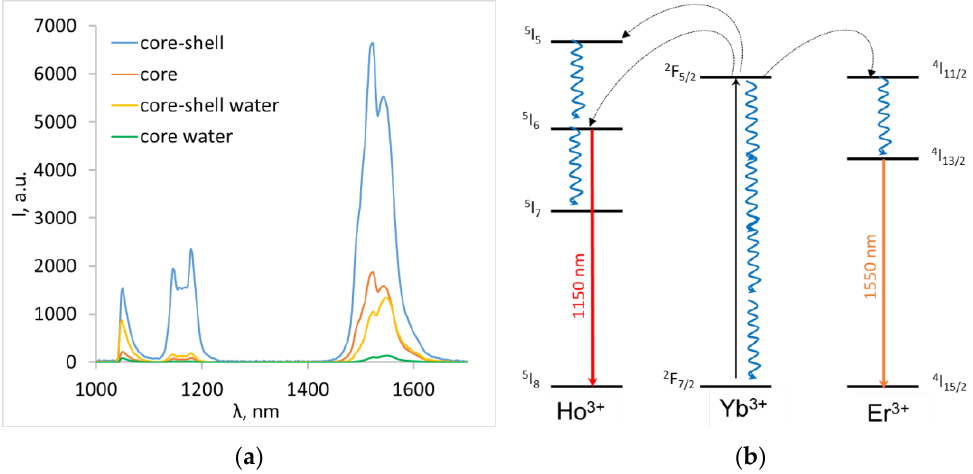
Figure 2. ( a ) The luminescence spectra of NaGdF 4 :Yb 3+ , Ho 3+ , Er 3+ core and core-shell nanoparticles measured at 30 °C in powder and in aqueous solution and ( b ) simplified energy level diagram of the Yb 3+ -, Ho 3+ -, and Er 3+ -emitting centers.